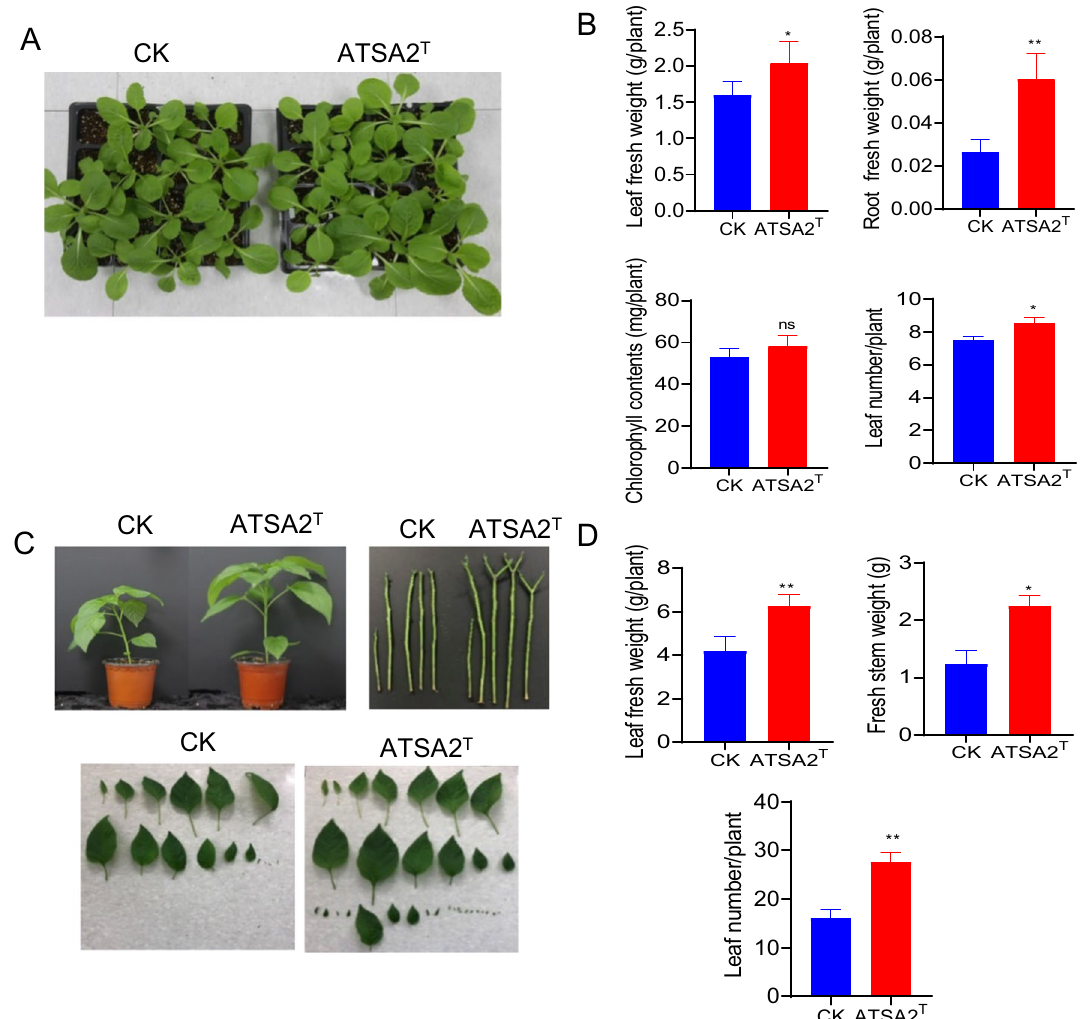
Fig. 1 Effect of the strain ATSA2 T on kimchi cabbage and pepper plant growth. The growth of kimchi cabbage ( A , B ) and pepper ( C , D ) with and without ATSA2 T inoculation were determined at 21 and 28 days after inoculation, respectively. A , C Representative photograph showing the effects of the strain ATSA2 T . B , D The average leaf fresh weight, root fresh weight, chlorophyll content, and leaf number of plants inoculated with ATSA2 T . Error bars indicate the standard deviation of the mean (n 5–15). Asterisks (*) indicate statistically significant differences between control (CK) and = ATSA2 T inoculation ( *P < 0.05, t -test). Experiments were repeated twice with similar